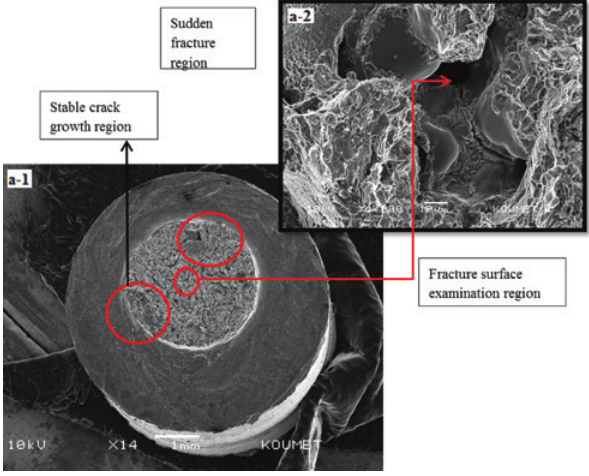
Fig. 8: The SEM image of fracture surface morphology of